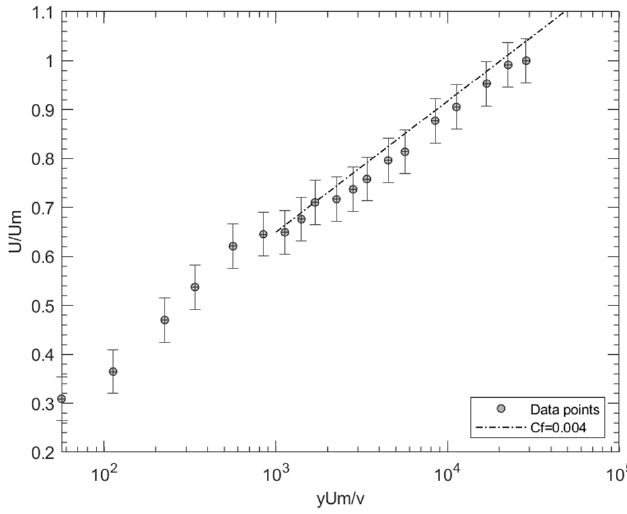
Figure 4. Semi-logarithmic plot with the best fit line of 𝐶 (cid:3033) .